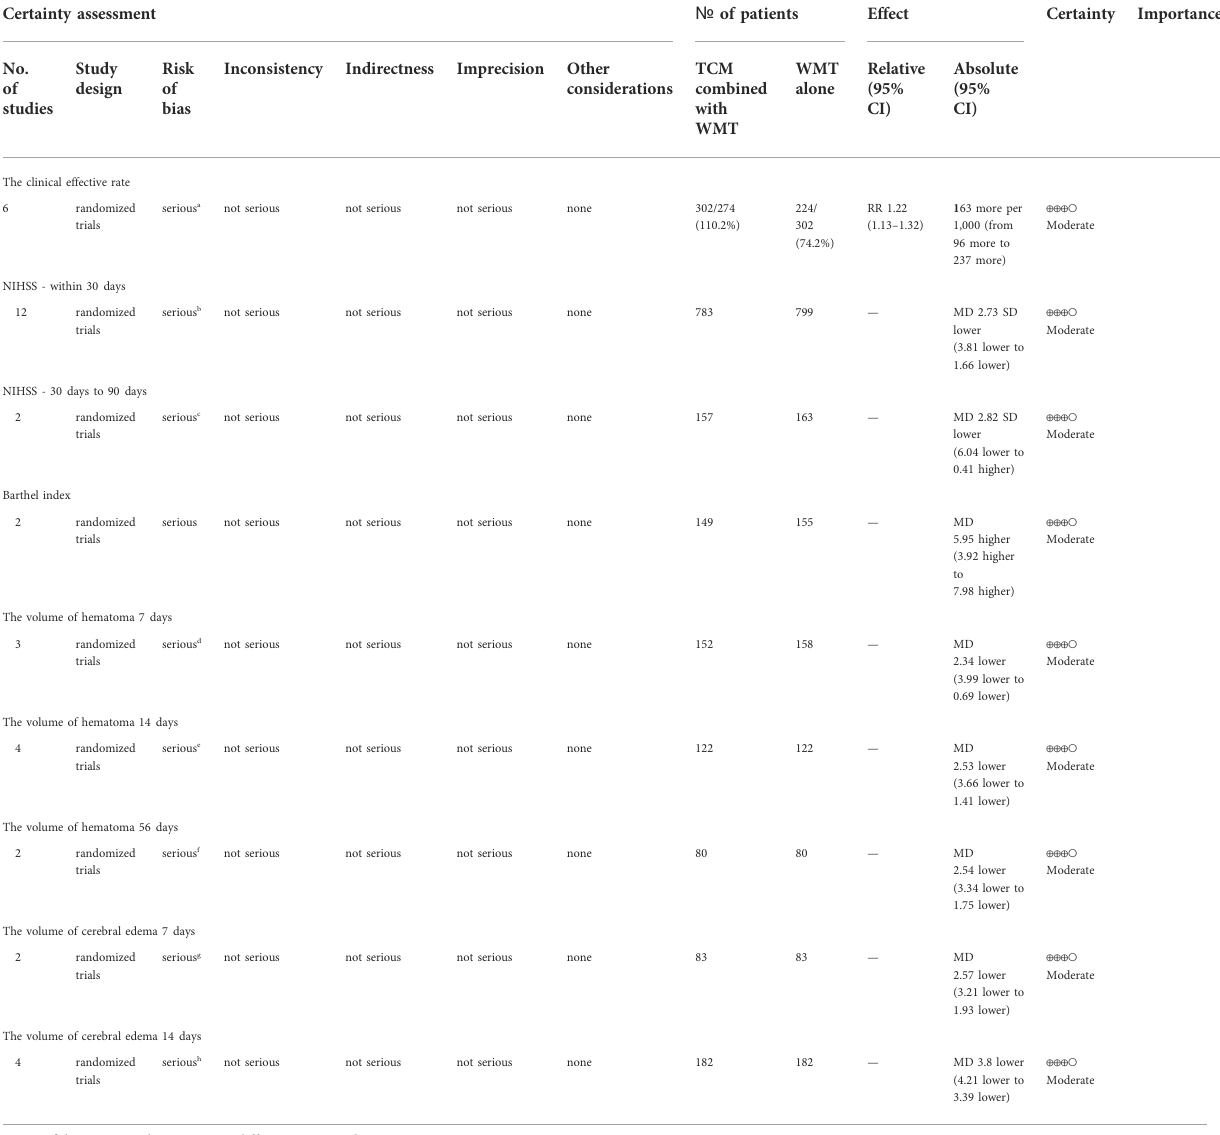
TABLE 3 GRADE summary of outcomes for blood-activating Chinese medicine to patients with intracerebral hemorrhage. Certainty assessment № of